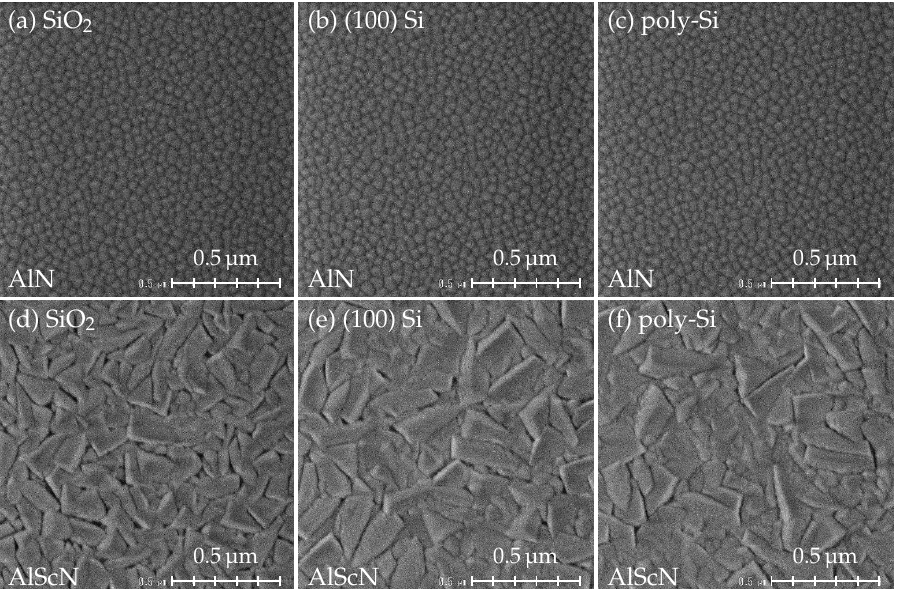
Figure 1. SEM surface view of 1µm AlN deposited directly on ( a ) SiO 2 , ( b ) (100) Si, ( c ) poly-Si, and 1µm AlScN deposited directly on ( d ) SiO 2 , ( e ) (100) Si, ( f ) poly-Si without a seed layer.without a seed layer.